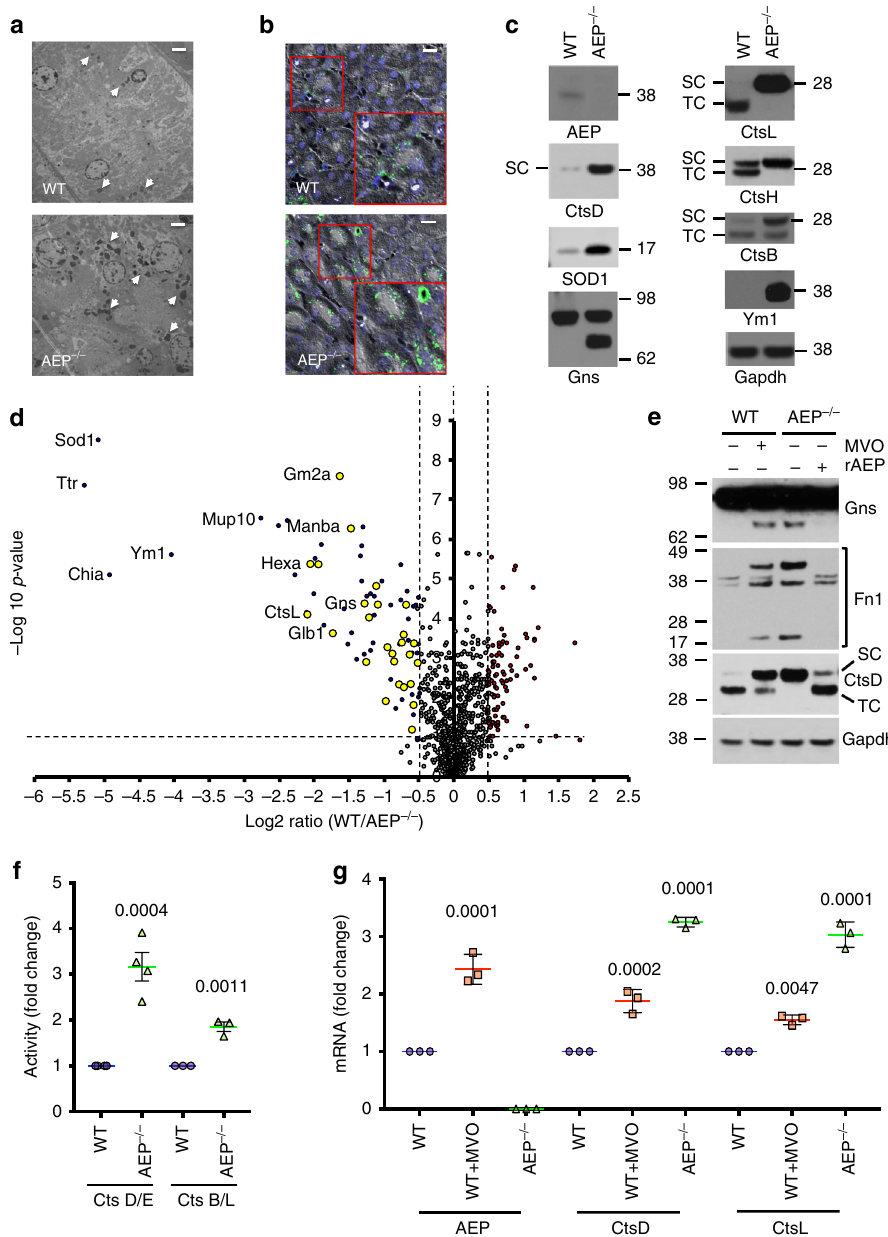
Fig. 1 In vivo SILAC labelling reveals elevated lysosomal hydrolase expression induced by lack of AEP. a Transmission electron microscopy of WT (upper panel) and AEP − / − (lower panel) kidney sections. Arrows indicate lysosomes. (Scale bar = 2 μ m) b Immuno fl uorescence showing more prominent lysosomes (CtsD, green) in AEP − / − kidney sections (lower panel) compared to WT kidney sections (upper panel). (Scale bar = 20 μ m). c Western blot analysis con fi rming the accumulation in AEP − / − kidneys of proteins identi fi ed by mass spectrometry. d Volcano plot showing proteins over-represented (blue dots, lysosomal proteins highlighted in yellow) or under-represented (red dots) in AEP − / − lysosomal kidney fractions against the − log10 p -value for three independent experiments. Dotted line on y axis indicates p value < 0.05. e Acute AEP inhibition with MVO26630 recapitulates hydrolase induction in WT MEF and AEP reconstitution reverses it in AEP − / − MEF. f Induction of CtsD/E and CtsB/L activities in AEP − / − MEF compared to WT MEF. Data are the average ± SD of n = 4 biologically independent samples for CtsD/E or n = 3 biologically independent samples for CtsB/L. Statistical signi fi cance was calculated using a two-sided unpaired t- test. g Semi-quantitative RT-PCR analysis of mRNA levels for different cathepsins in WT MEF, WT MEF treated overnight with 50 μ M MVO26630 and AEP − / − MEF. Data are the average ± SD of n = 3 biologically independent samples. Statistical signi fi cance